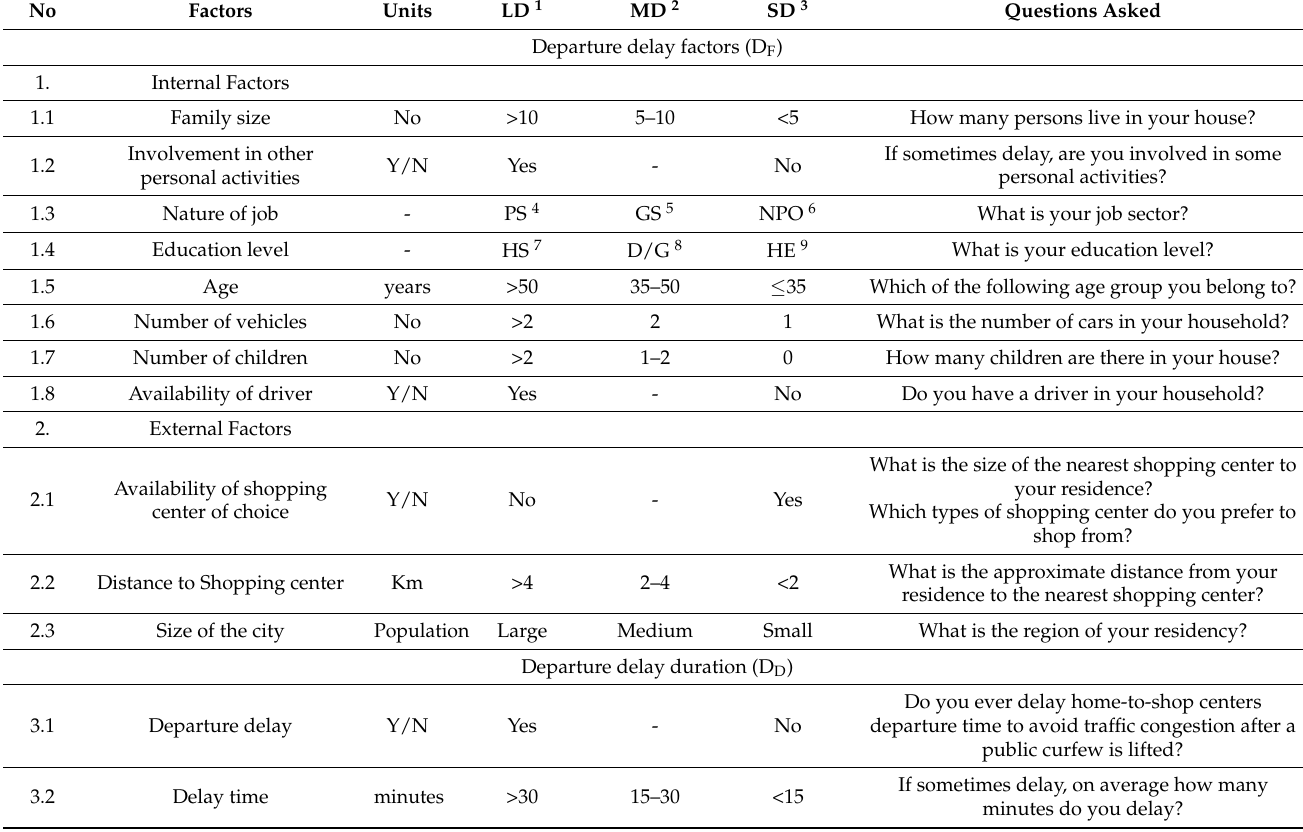
Table 1. Internal and external factors for evaluating commuter home-to-shopping center departure delay after COVID-19 curfew